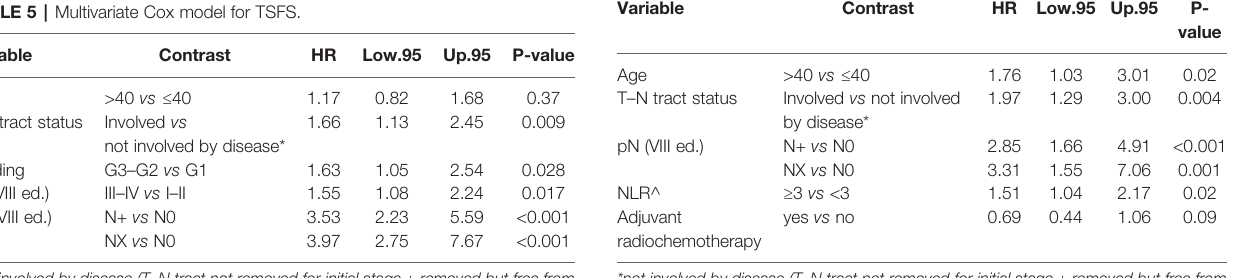
TABLE 5 | Multivariate Cox model for TSFS.